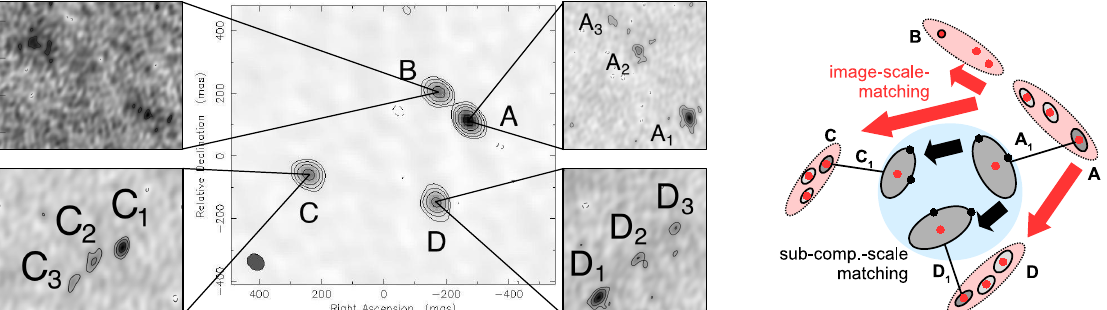
Figure 5. Observational data of B0128 ( left ): MERLIN 5 GHz band showing four images of a quasar at z s = 3.124 ( centre ) and VLBA 8.4 GHz details of all multiple images, revealing that images A , C , and D are resolved into three sub-components on milli-arcsecond scale, while B is most likely scatter-broadened. North is up and East is to the left. Schematic of applications of our model-independent approach ( right ): on image scale, the positions of the sub-components are used as reference points to apply our approach detailed in Section 2.3, on sub-component scale, the quadrupole moments of images A , C , and D are employed to determine local lens properties for the sub-components 1 and 3 using our approach detailed in Section 2.3. Image credits: [63,98]